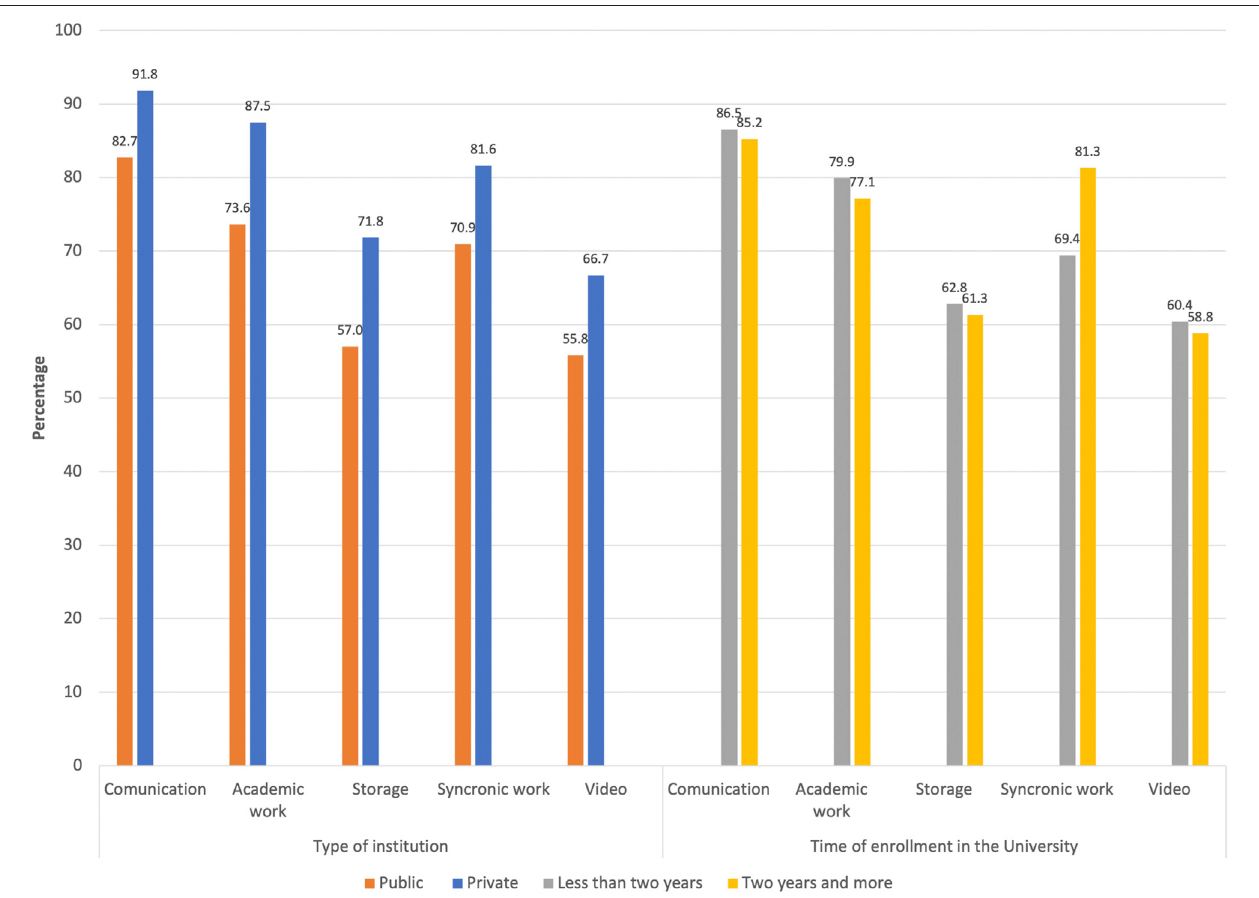
FIGURE 3 | Use of technological tools to support students ’ learning process during the emergency remote teaching model implementation, by type of institution and time of enrollment in the university.